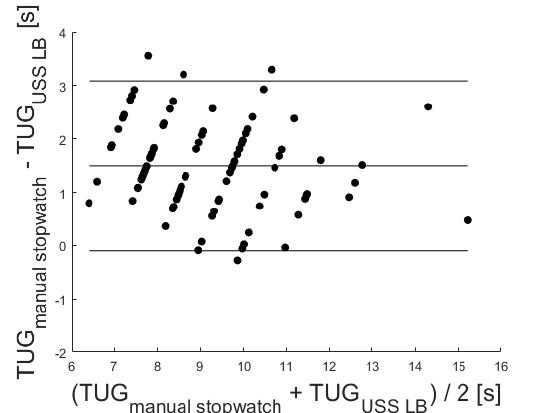
Figure 5. Linear regression among the manual stopwatch and the USS’s LB measurements for the TUG test.